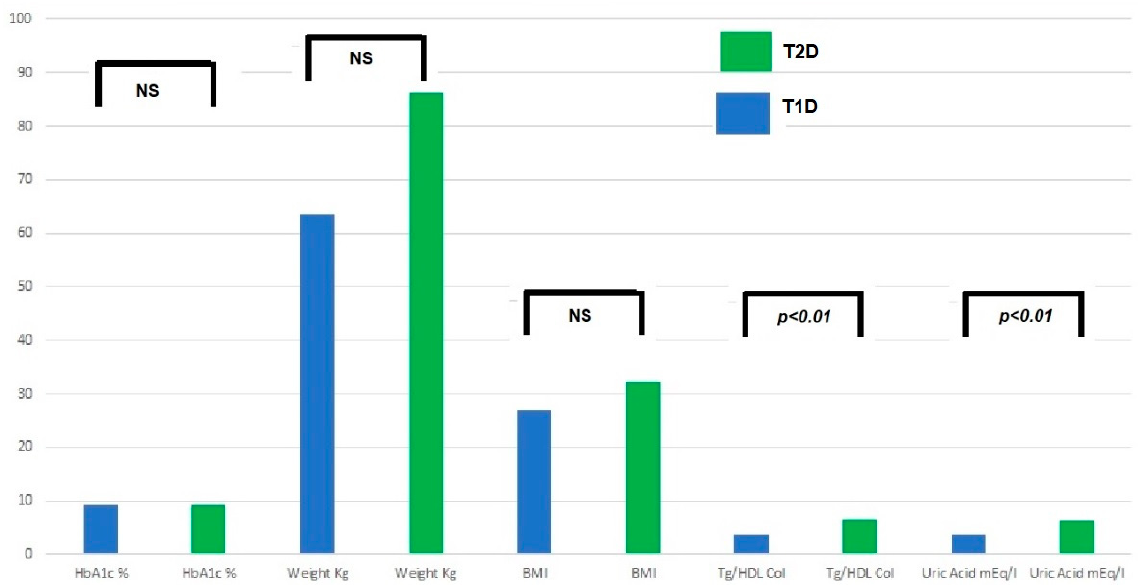
Figure 2. Prevalence of patients with high TG/HDL ratio and high uric acid.